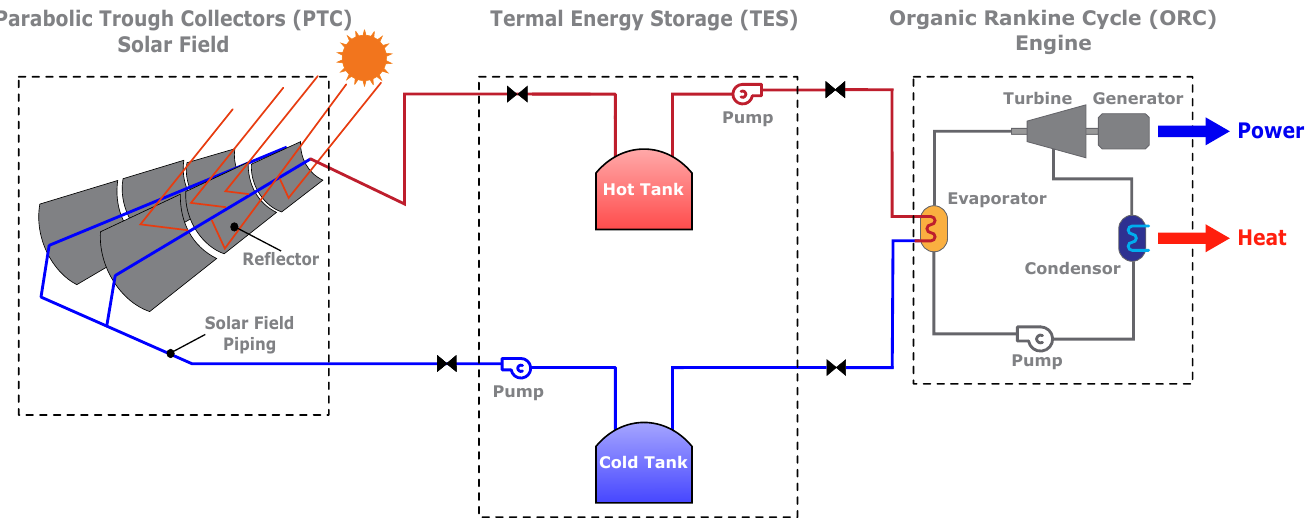
Figure 3. Schematic of a typical MicroCSP system with a PTC, a two-tank TES, and an ORC engine.